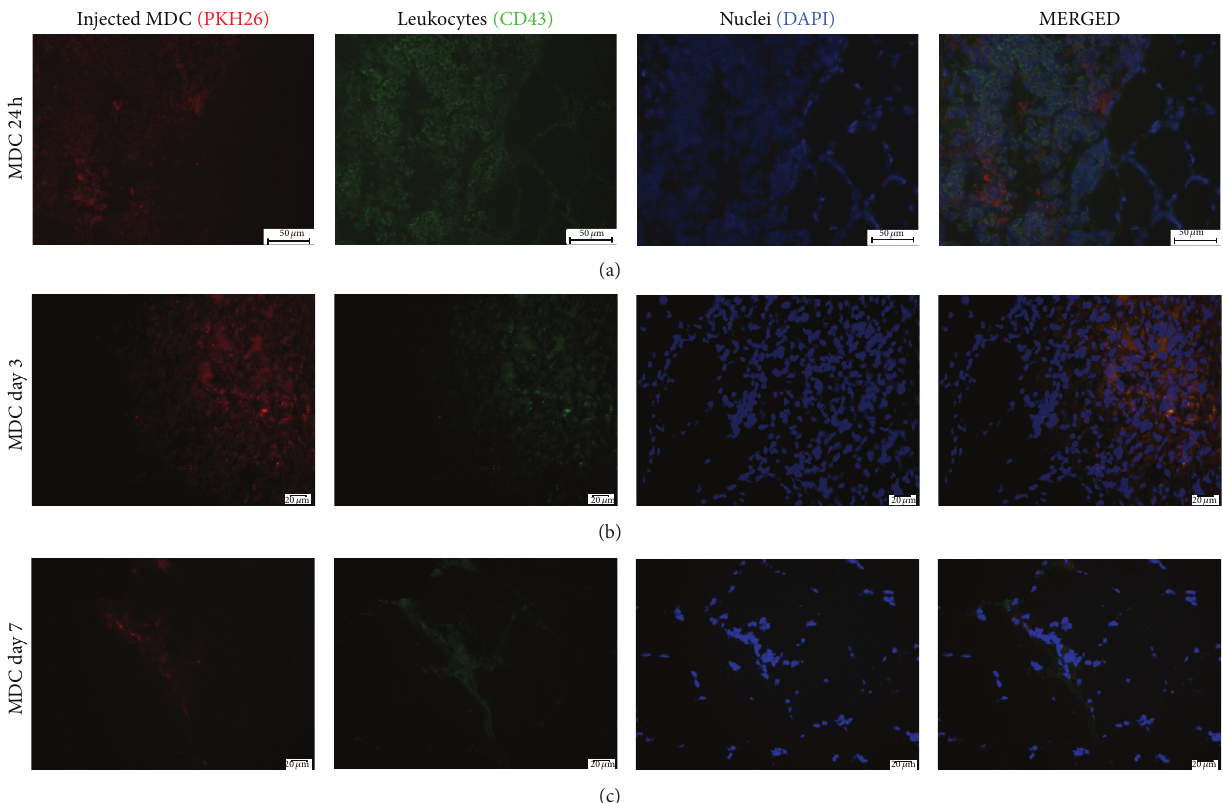
Figure 5: Immunohistochemical staining in different time points. Leukocytes (CD43 antigen stained with Alexa 488 (green)) are infiltrating the cluster of transplanted MDC (PKH26 (red)). Cell nuclei stained with DAPI (blue) in different time points. Scale bars: 50 𝜇